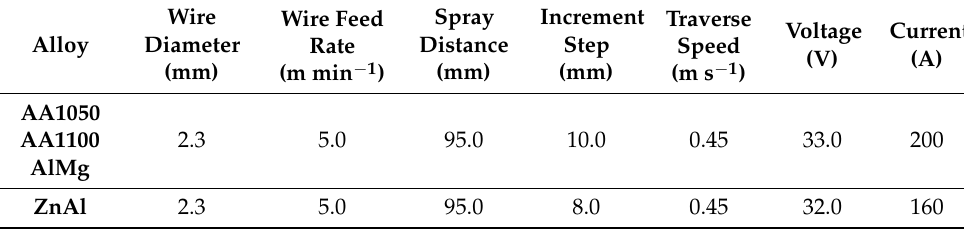
Table 3. Thermal spray process